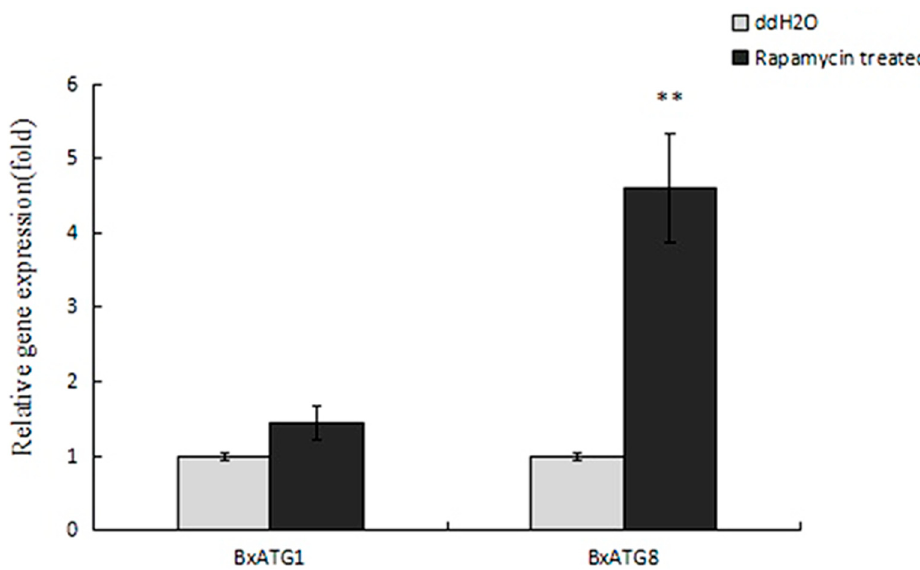
Figure 3. The expression level of BxATG1 and BxATG8 after treatment with a 50 mM concentration of rapamycin. Data represent mean ± SD from three independent experiments. Bars show standard deviations of the mean. Asterisks on top of the bars indicate statistically significant differences (** p < 0.01, Student’s t -test).